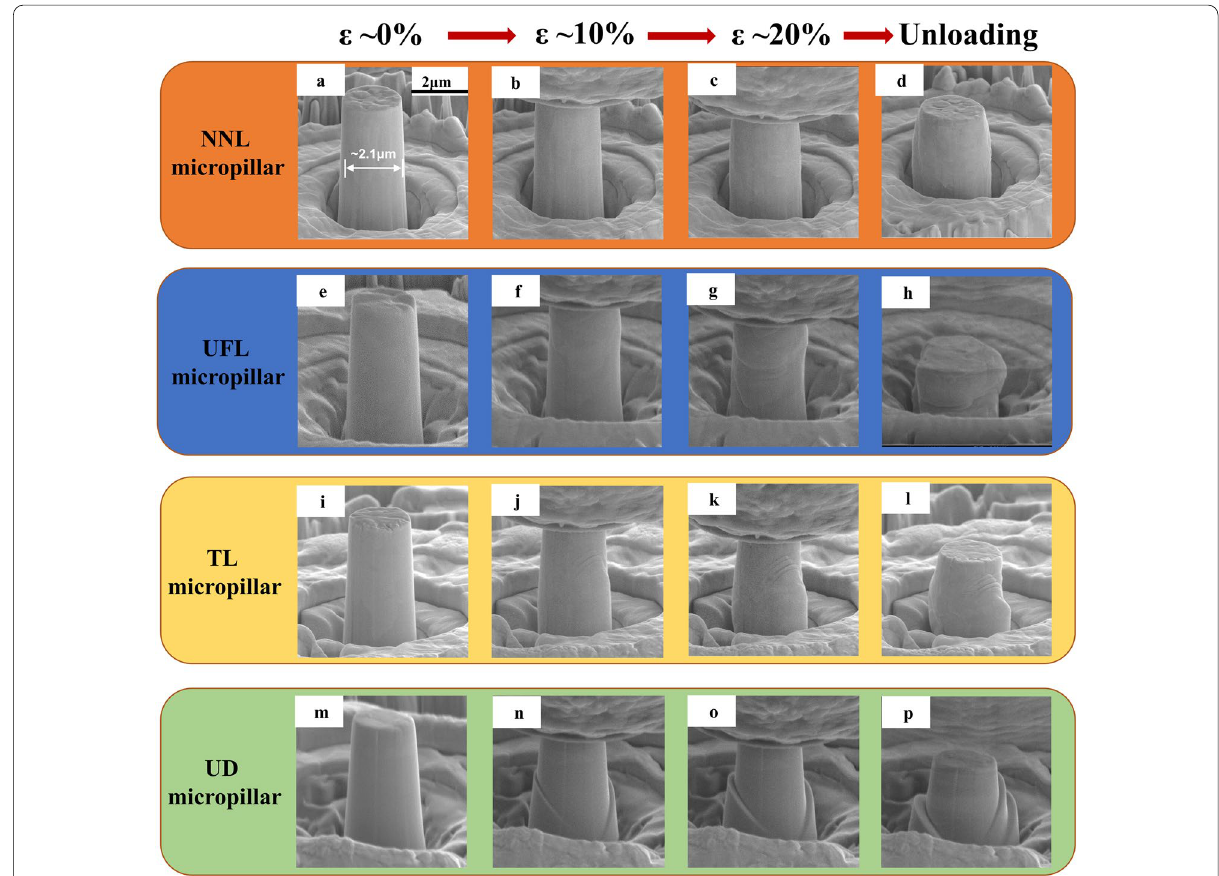
Figure 9 SEM snapshots of the ( a )–( d ) NNL, ( e )–( h ) UFL, ( i )–( l ) TL and ( m )–( p ) UD micropillar evolution during testing